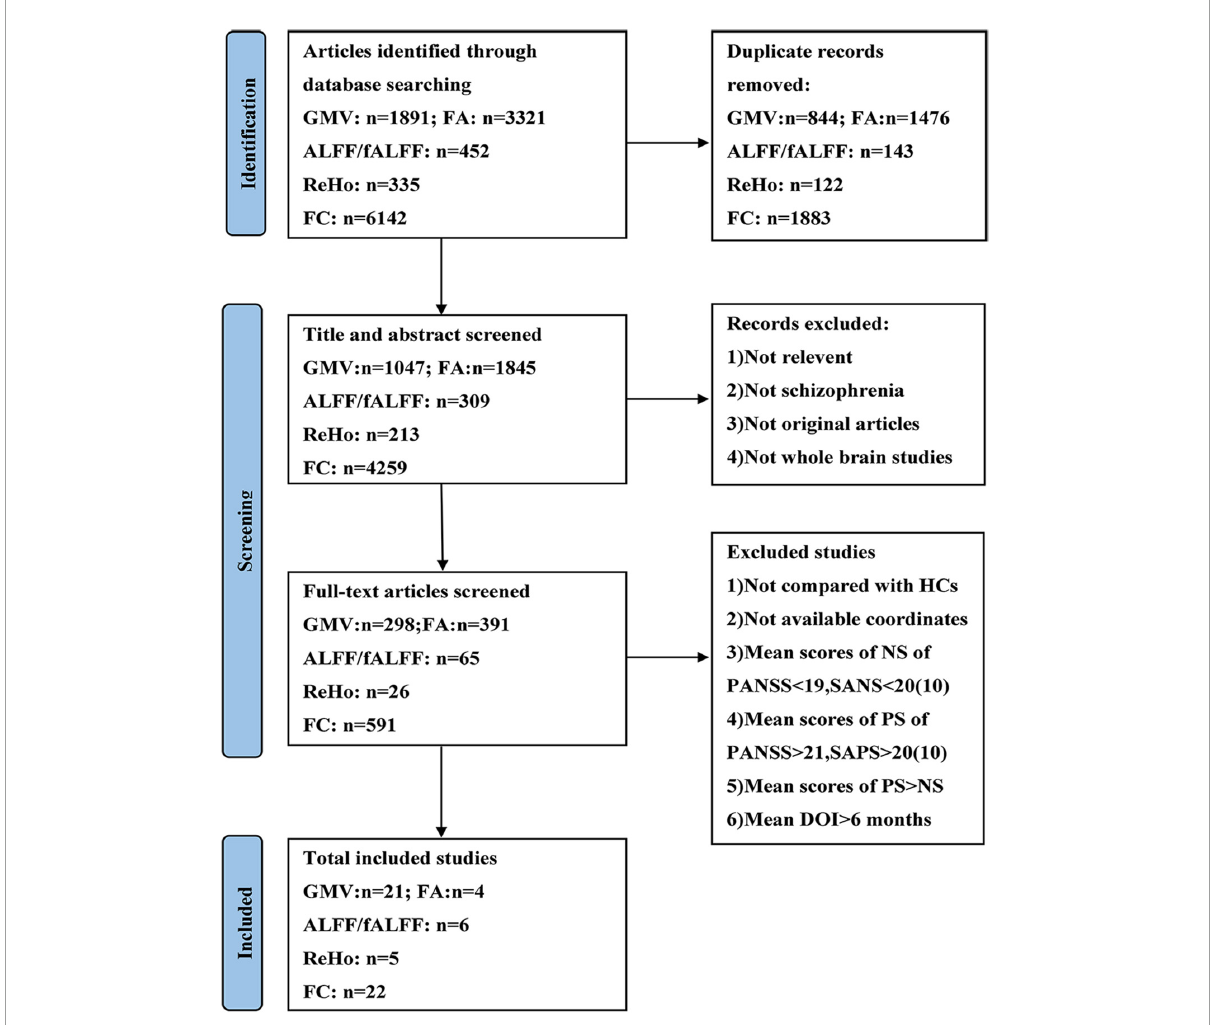
FIGURE1 Flow diagram showing the process of identifying relevant studies. GMV, gray matter volume; FA, fractional anisotropy; ALFF, amplitude of low-frequency fluctuation; fALFF, fractional amplitude of low-frequency fluctuation; ReHo, regional homogeneity; FC, functional connectivity; HCs, healthy controls; NS, negative symptoms; PS, positive symptoms; PANSS, Positive and Negative Syndrome Scale; SANS, Scale for the Assessment of Negative Symptoms; SAPS, Scale for the Assessment of Positive Symptoms; DOI, duration of